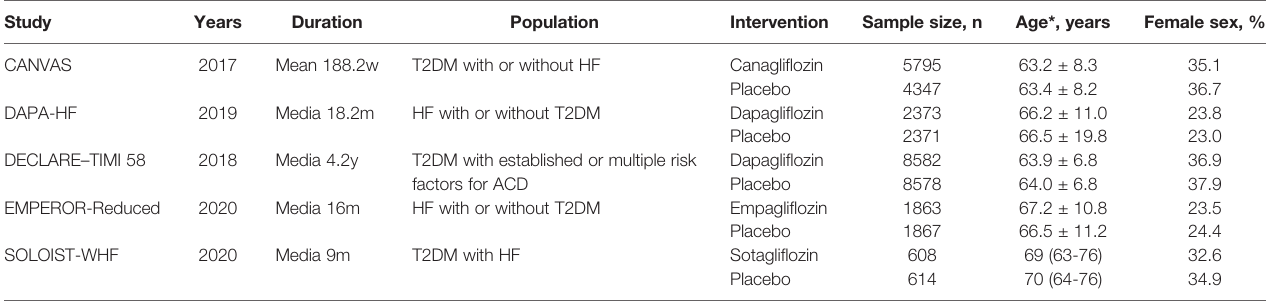
TABLE 1 | Study characteristics of the main study of 5